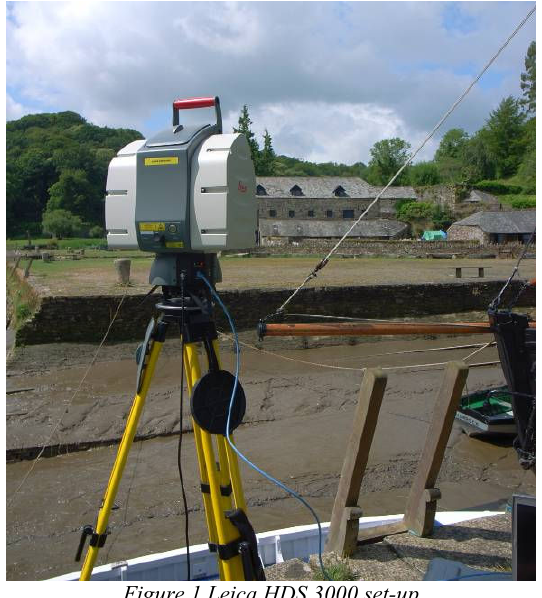
Figure 1 Leica HDS 3000